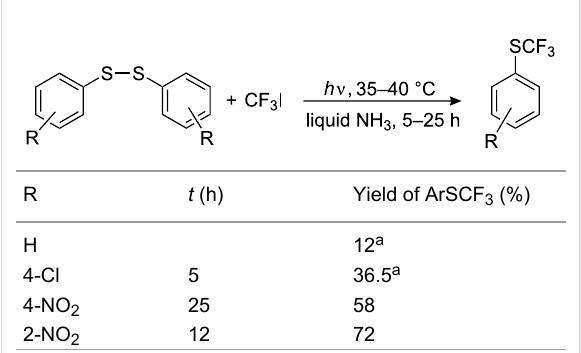
Table 13: UV irradiation of CF 3 I with diaryl disulfides in a sealed quartz tube [157].